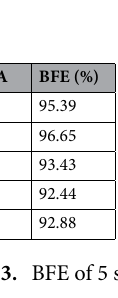
Table 2. Conformity of masks according to AFNOR SPEC S76-001 Category 1 and EN14683 Type I limit.